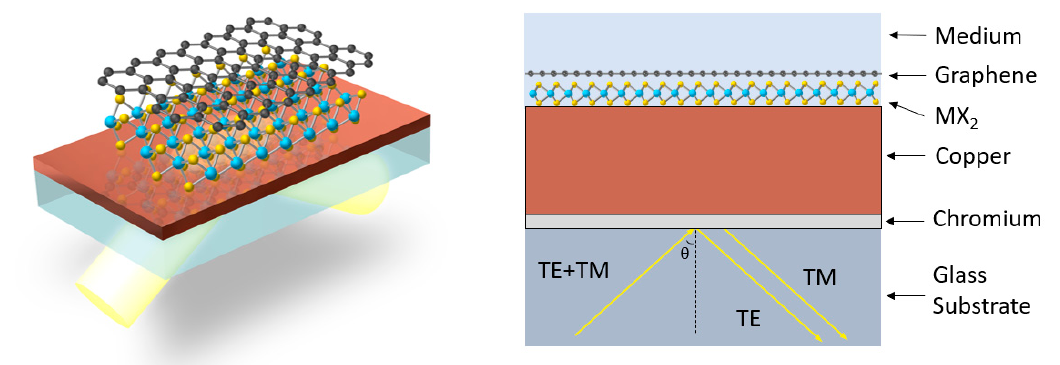
Figure 1. Schematic picture of Cu—TMDCs—graphene enhanced SPR biosensor system. The difference of GH shift for TM and TE waves are measured in order to improve the signal to noise ratio since the signals for TE waves can be used as a reference.